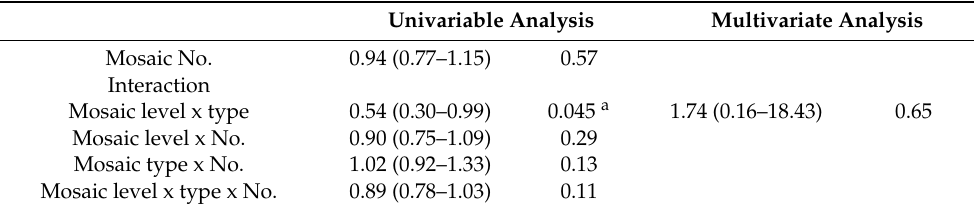
Univariable Analysis Multivariate Analysis